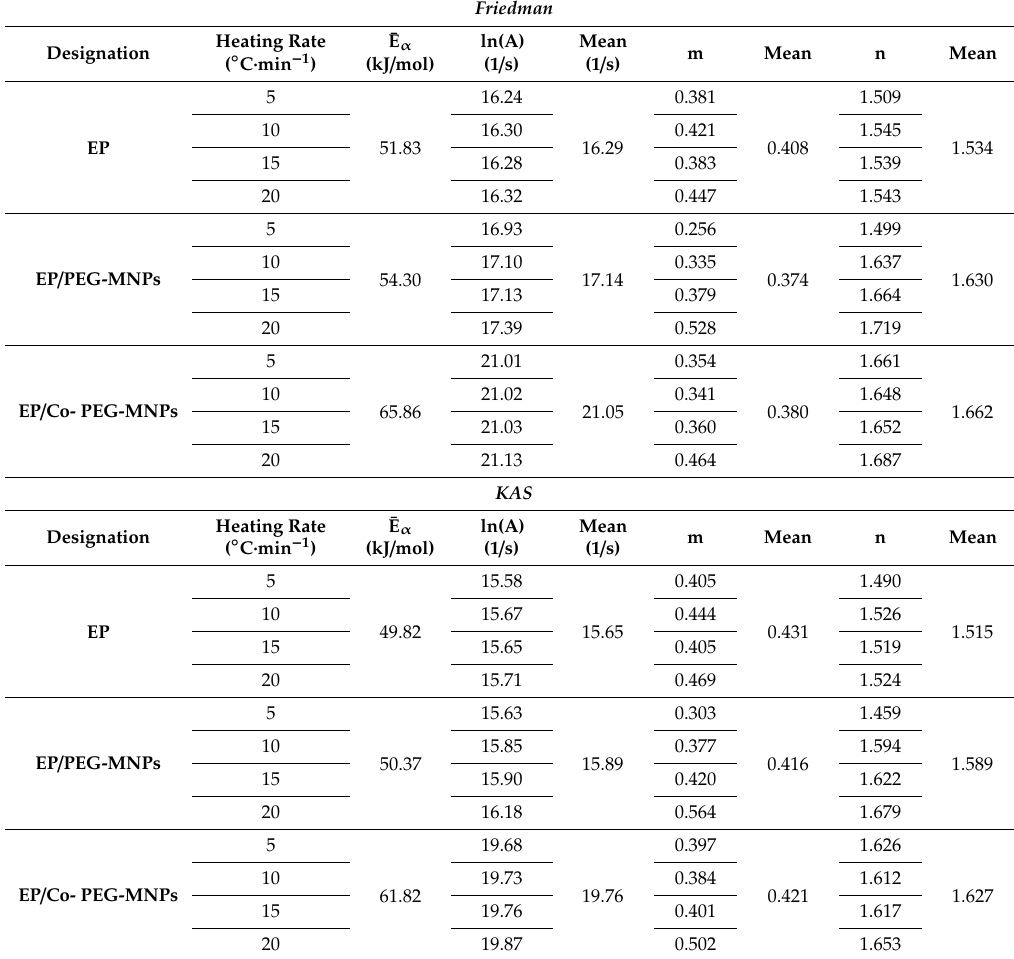
Table 3. The kinetic parameters obtained at di ff erent heating rates using Friedman and KAS models. Friedman